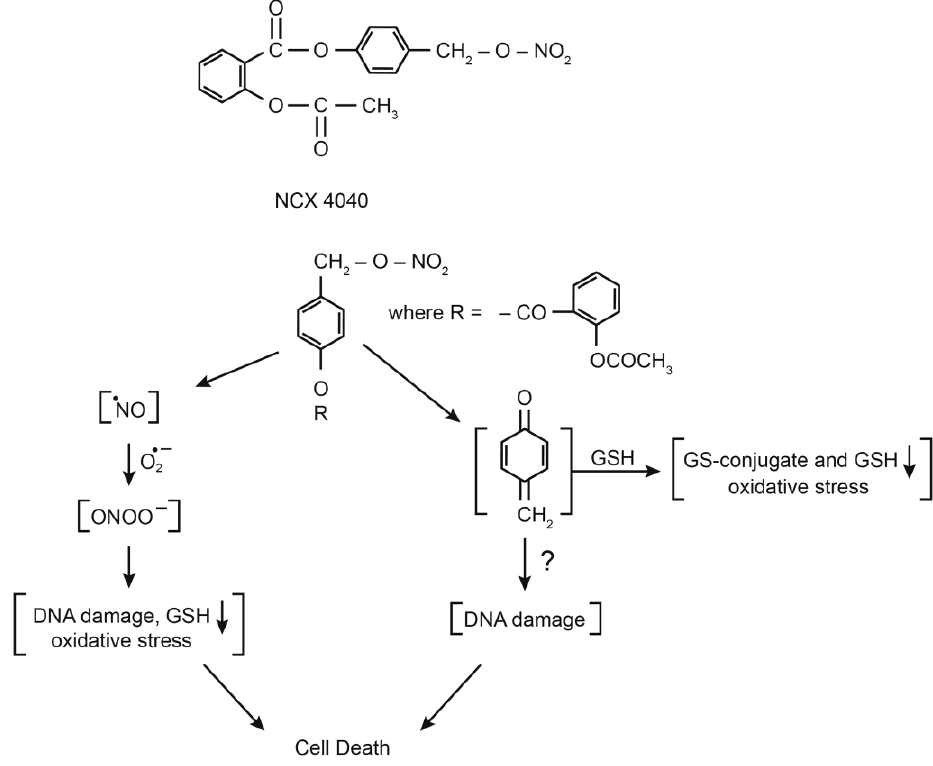
Figure 1. Structure of NCX4040 and its known/proposed mechanisms of cytotoxicity. Because NCX4040 was cytotoxic to both OVCAR-8 and OVCAR-8-derived